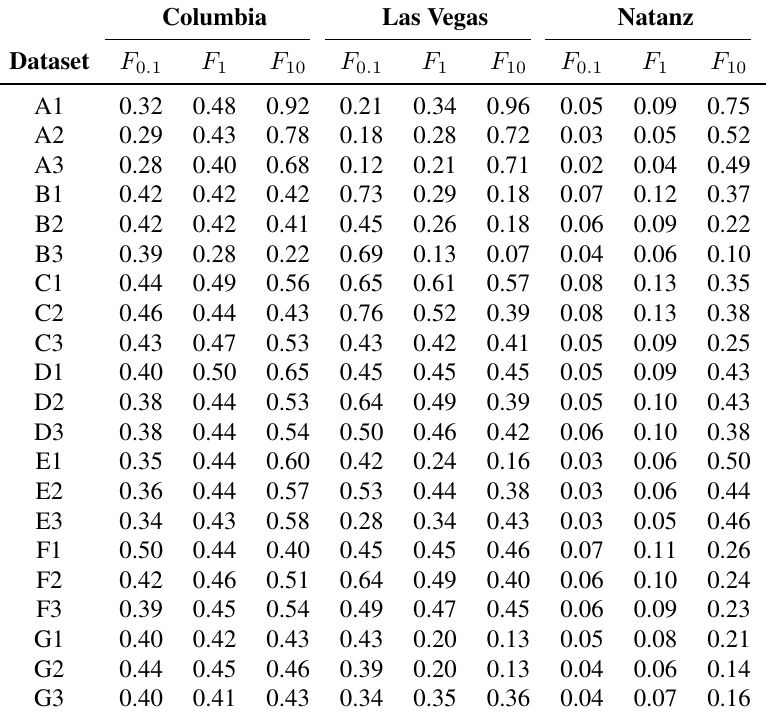
Table 14. Analysis of decision tree (CART) change prediction results using a generalized